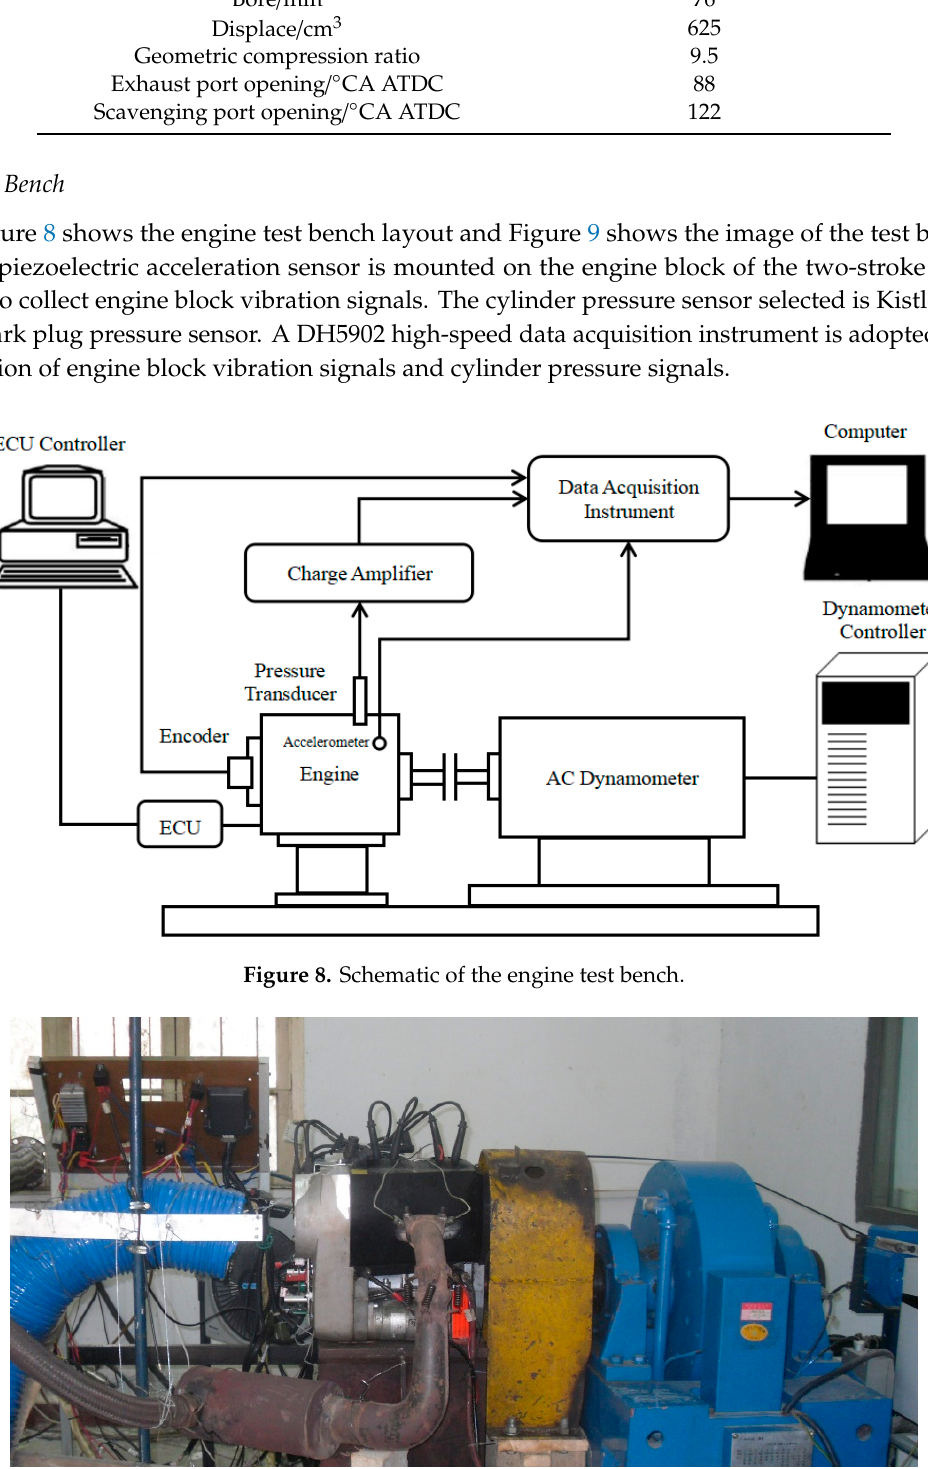
Figure 9. Image of the engine test bench.